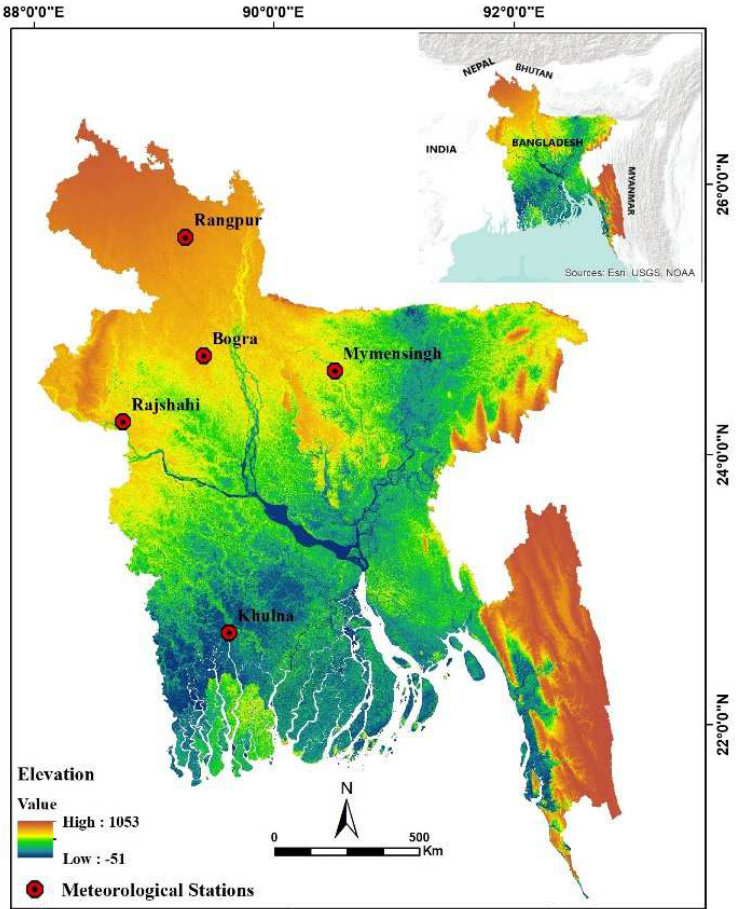
Figure 1. Study area and weather stations.